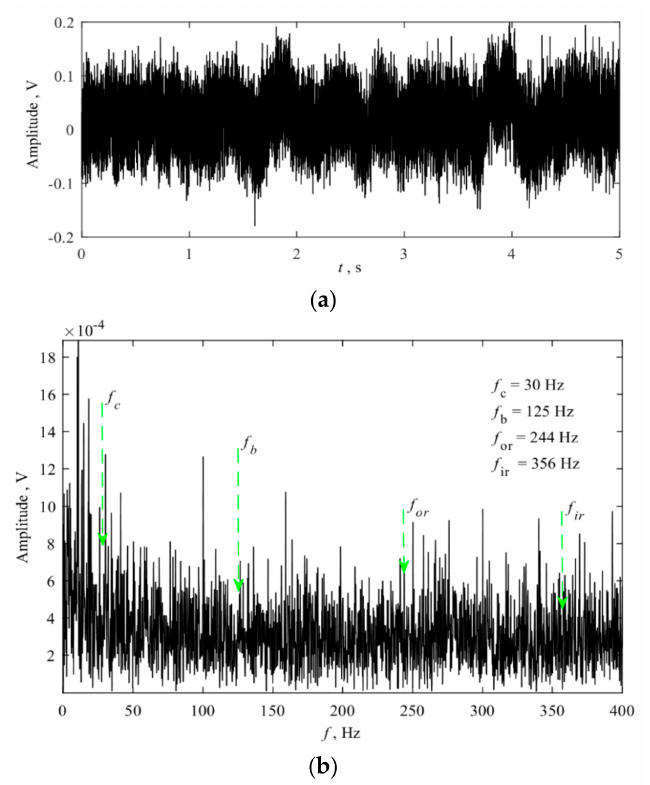
Figure 8. The signal of a normal MWA: ( a ) time domain waveform; ( b ) envelope spectrum.